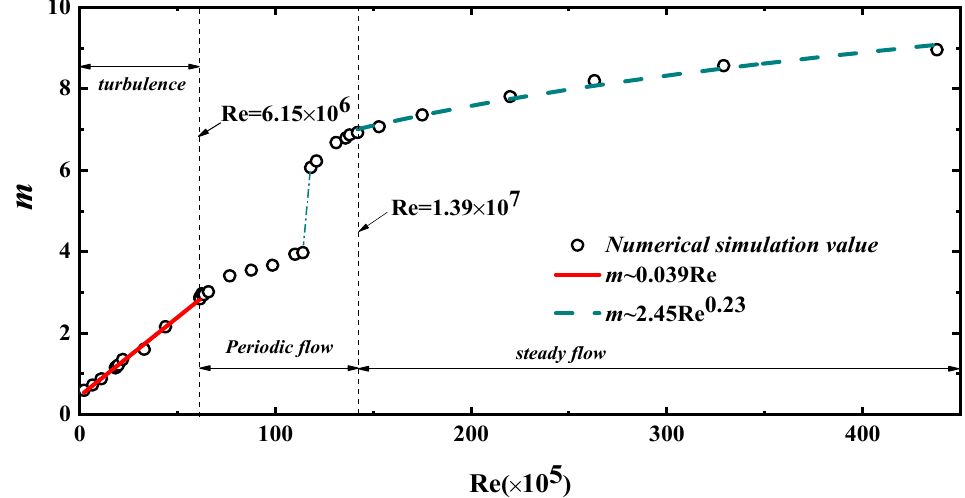
Figure 10. The change of effective heat coefficient m with Re number.